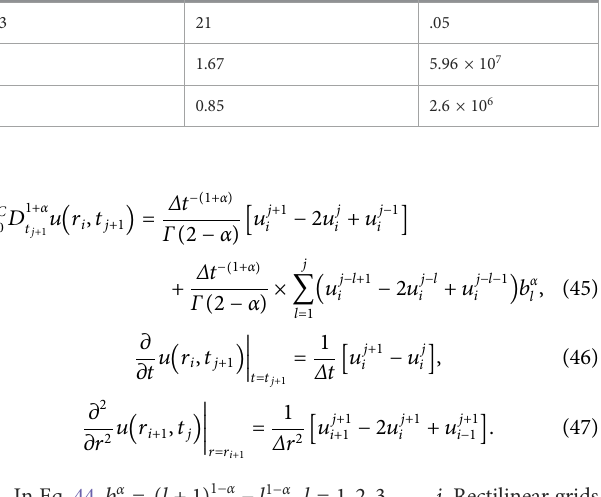
TABLE 1 Contains the numerical values of nanoparticles and different base fl uids at room temperature 25 ° presented in (Usman et al., 2018).